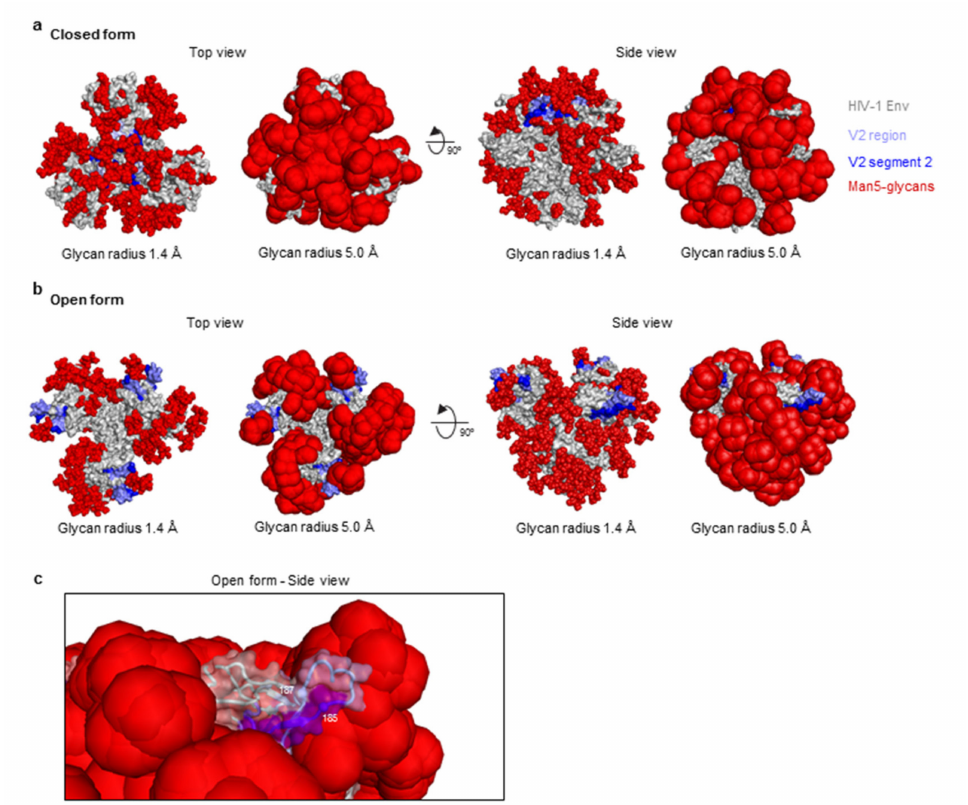
Figure 7. Modeling of HIV-1 Env V2 segment 2 surface accessibility. ( a ) Surface representation of the “closed” form of the HIV-1 Env trimer (PDB ID: 5FYJ) in two orientations with top and side views. The V2 region (residues 157–196) is colored light blue, and segment 2 in dark blue. HIV-1 Env Man5-glycans are modeled with two radii (1. 4 Å, and 5.0 Å) and colored red. ( b ) HIV-1 Env in the “open” form (PDB ID: 5VN8) is shown in surface representation with glycans and V2 depicted as in ( a ). ( c ) Close-up view of the V2 region (blue) in the “open” conformation in two